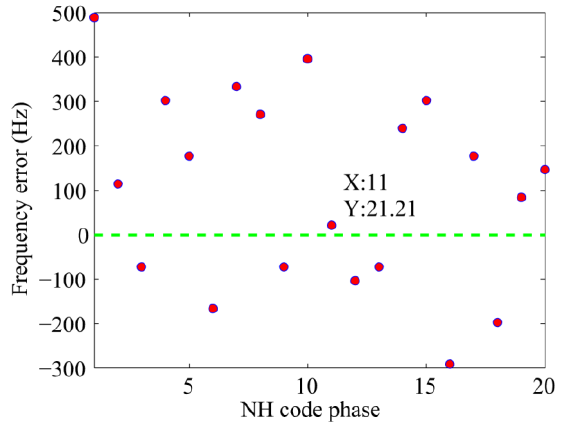
Figure 6. Frequency errors against different NH code phases.